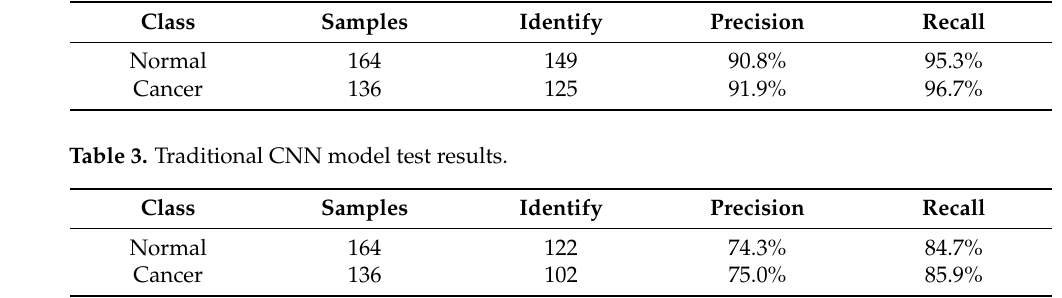
Table 2. CapsNet test results.